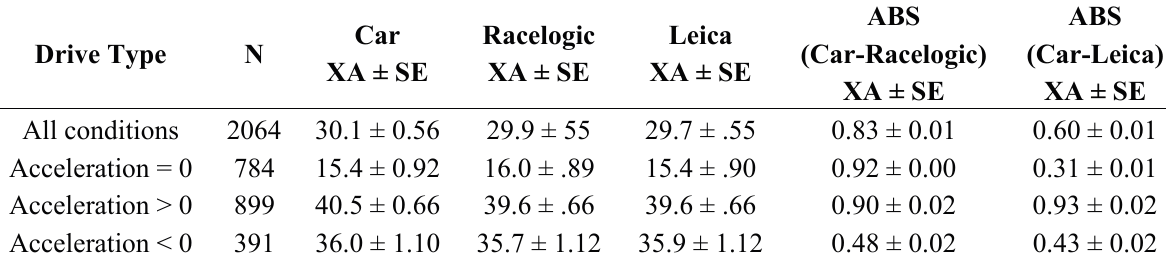
Table 2. Descriptive statistics for vehicle speedometer (Car), Racelogic, Leica, absolute difference Car-Racelogic, absolute difference Car-Leica (km/h). Legend: N—sample size, XA—mean, SE—standard error.